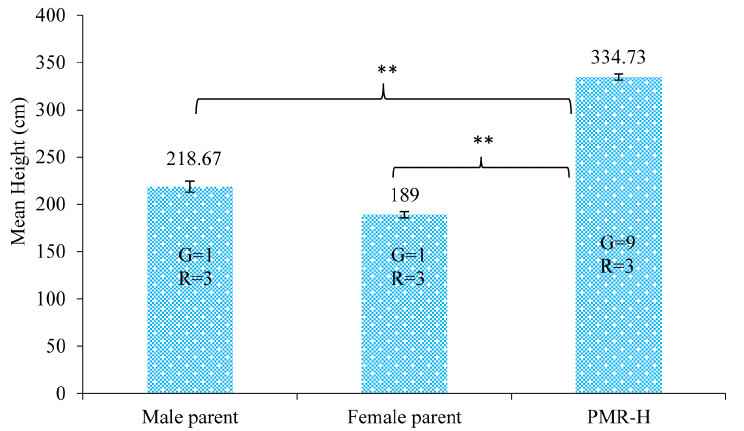
Figure 2. The mean heights of the high-growth allotriploid progeny (PMR-H), male parent, and female parent genotypes. Note: ** indicates a significant difference between means at the 0.01 level. G represents the number of genotypes. R represents the number of replicates for each